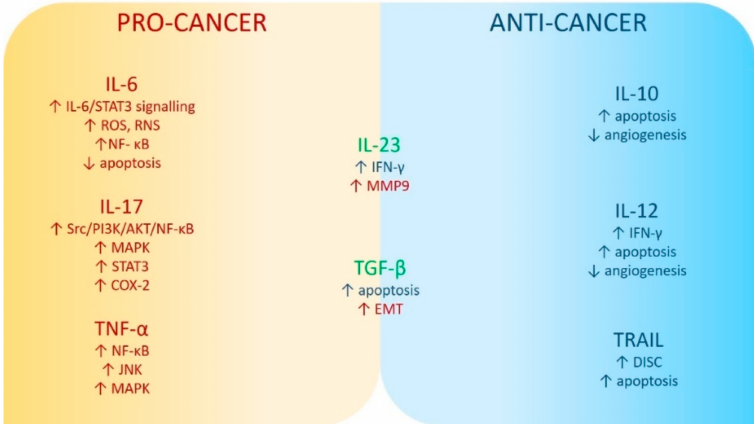
Figure 1. Mechanisms of pro- and anti-carcinogenic activity of selected inflammatory factors.